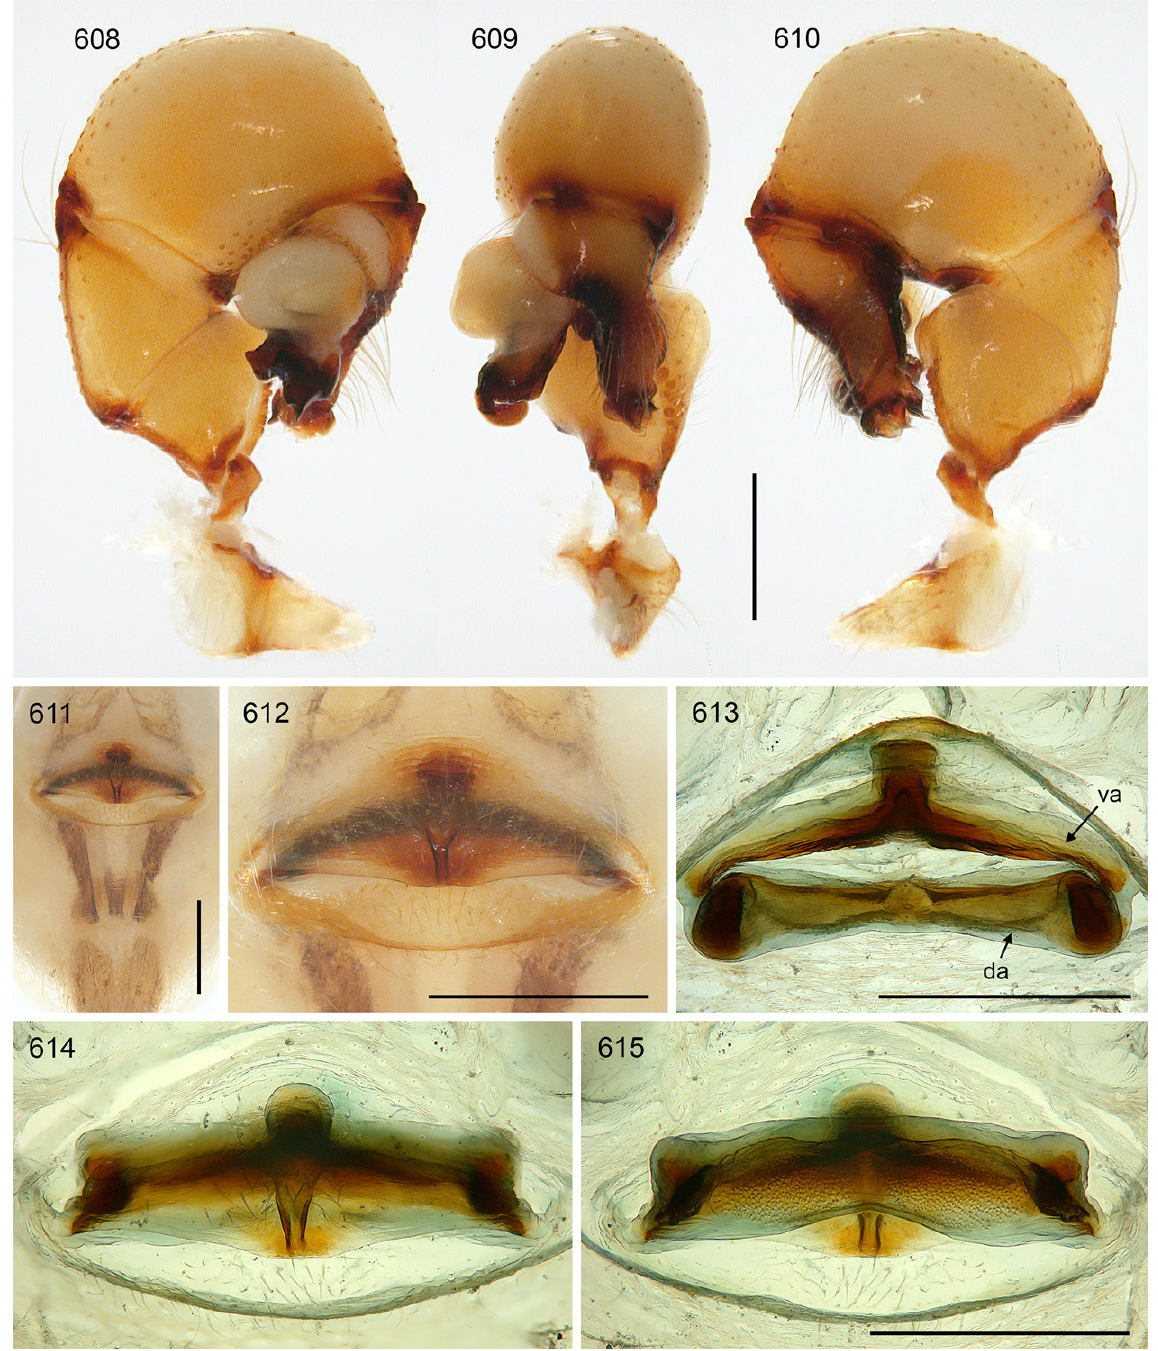
Figs 608–615. Crossopriza pristina (Simon, 1890); male from Eritrea, Massaua (MNHN Ar 10510), syntype female from Yemen, Aden (MNHN Ar 10511). 608–610 . Left male palp, prolateral, dorsal, and retrolateral views. 611–612 . Female abdomen and epigynum, ventral views. 613–615 . Female internal genitalia, dorsal view (with dorsal arc tilted backwards), ventral view, and regular dorsal view. Abbreviations: da = dorsal arc; va = ventral arc. Scale bars = 0.5